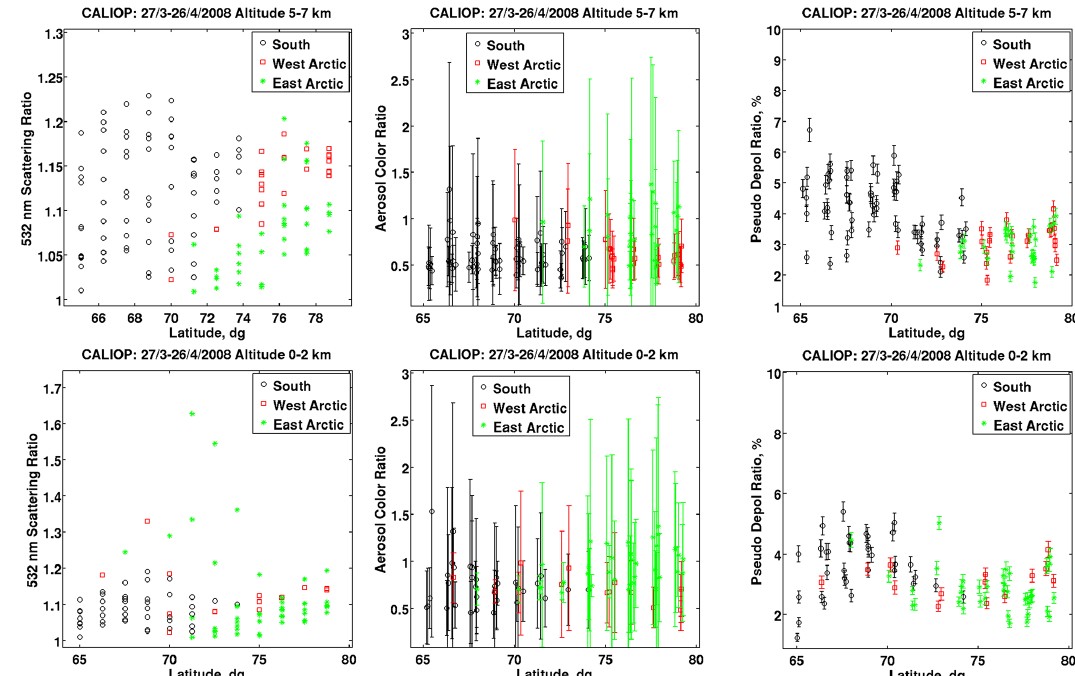
Figure 12. Latitudinal distribution of 532nm backscatter ratio (left), aerosol colour ratio (middle) and pseudo-depolarization ratio (right) for filtered level 1 CALIOP in April 2008 at altitudes < 2km (bottom) and between 5 and 7km (top). The origin of the layers are estimated with FLEXPART (see